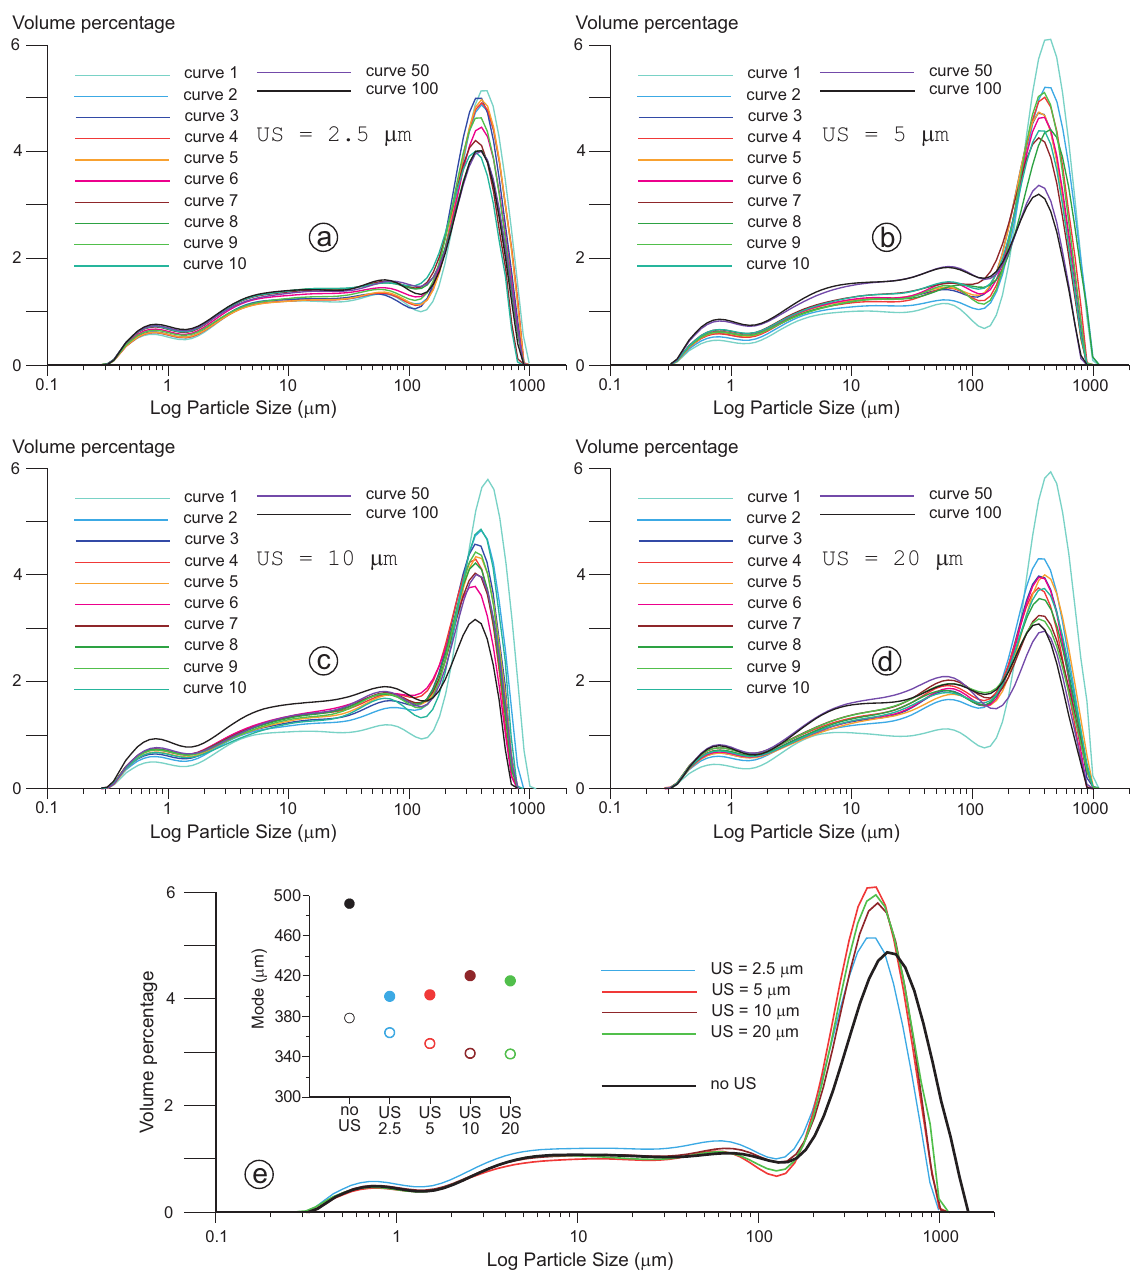
Fig. 17. (a) Granulometric curves computed for the first 10 runs of test US2 . 5 5 performed on sub-sample aliquot CABRE3l, compared with the ones from the 50th and 100th run. (b) Granulometric curves computed for the first 10 runs of test US5 5 performed on sub-sample aliquot CABRE3m, compared with the ones from the 50th and 100th run. (c) Granulometric curves computed for the first 10 runs of test US10 5 performed on sub-sample aliquot CABRE3n, compared with the ones from the 50th and 100th run. (d) Granulometric curves computed for the first 10 runs of test US20 5 performed on sub-sample aliquot CABRE3o, compared with the ones from the 50th and 100th run. (e) First run granulometric curves from the four tests listed above, compared with the first run curve from test MP2000 5 on sub-sample aliquot CABRE3d (Fig. 9). The inset graph shows the modal values of the same first run cuves (filled dots, same colour code) compared with modal values averaged over the first 10 runs of the corresponding tests (empty dots, same colour